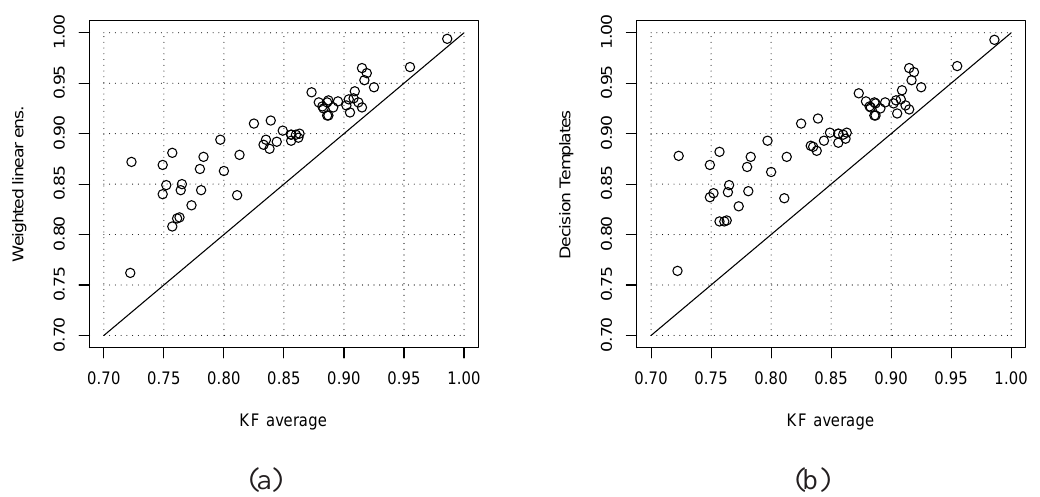
Figure 3: Comparison of AUC results between average kernel fusion and ensemble data integra- tion methods with 2 noisy data sets. Points represent the AUC score of kernel fusion (abscissa) and ensemble (ordinate) methods for 56 GO terms. (a) Average KF vs Weighted ensembles (b) Average KF vs Decision